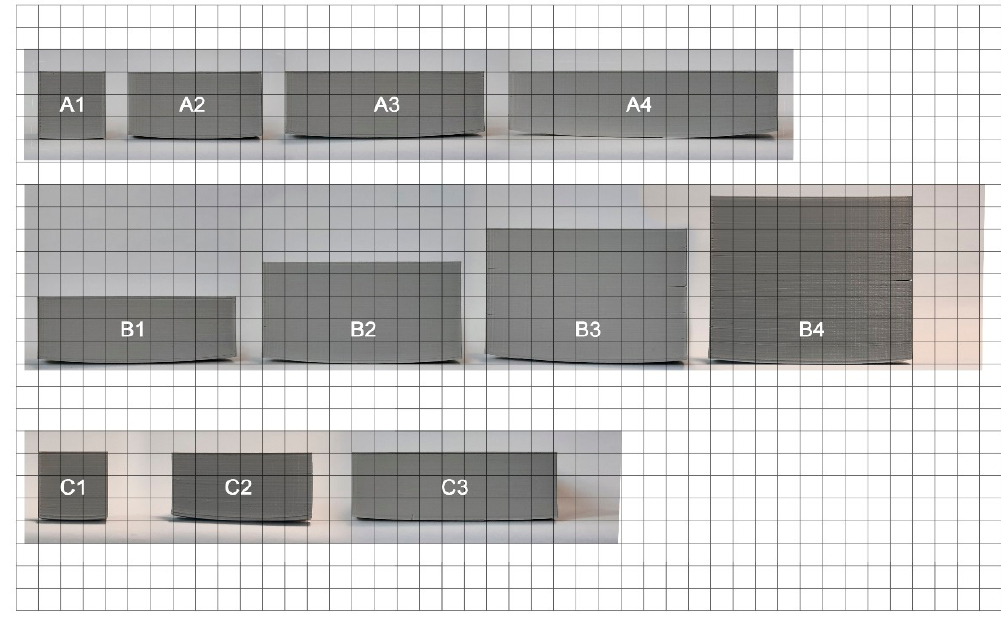
Figure 7. Photos of printed cubes for group A to C, placed on a 1 × 1 cm 2 grid.